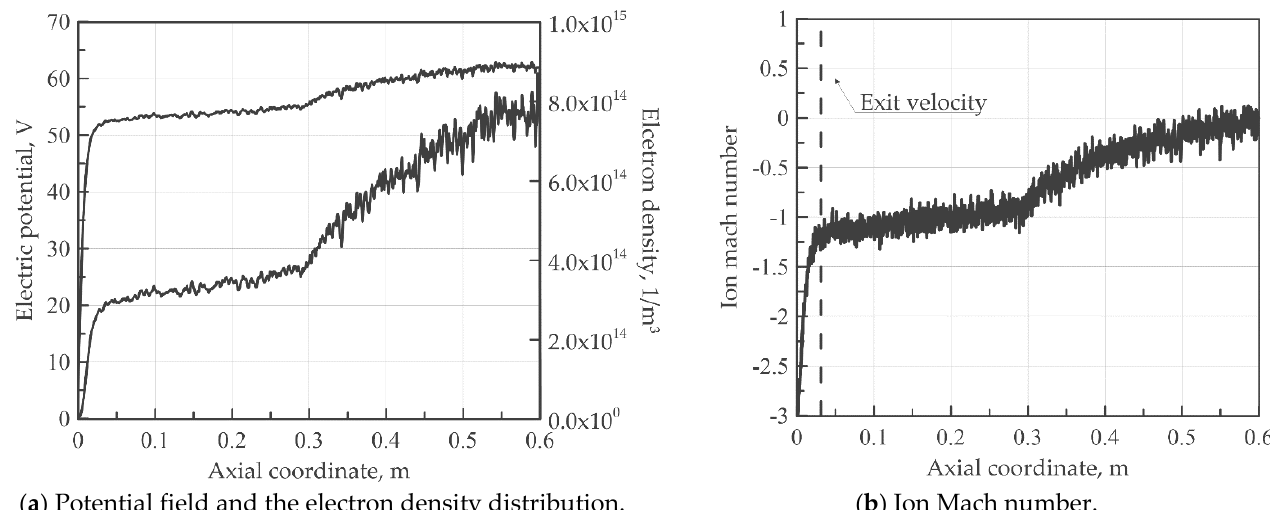
Figure 10. Results of the helicon double-layer thruster.